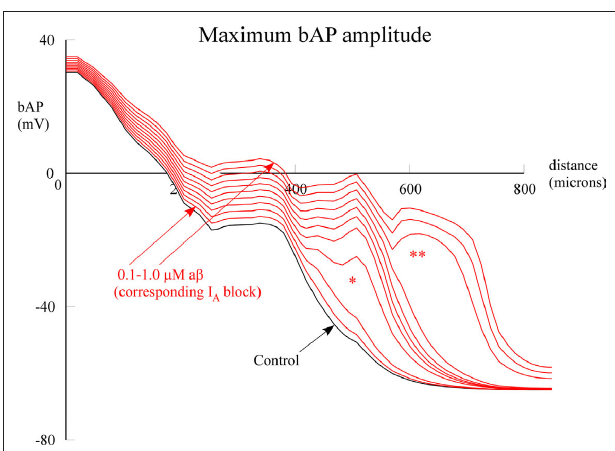
Figure 3 | Movie frame of normal (top) and a β applied (bottom) simulations 2 ms after the peak of the somatic spike. On the left are plots of instantaneous membrane potential along paths from the soma (0 μm) to a distal dendritic tuft compartment (849 μm) and oblique dendrites ( x -axis in μm, y -axis in mV, paths